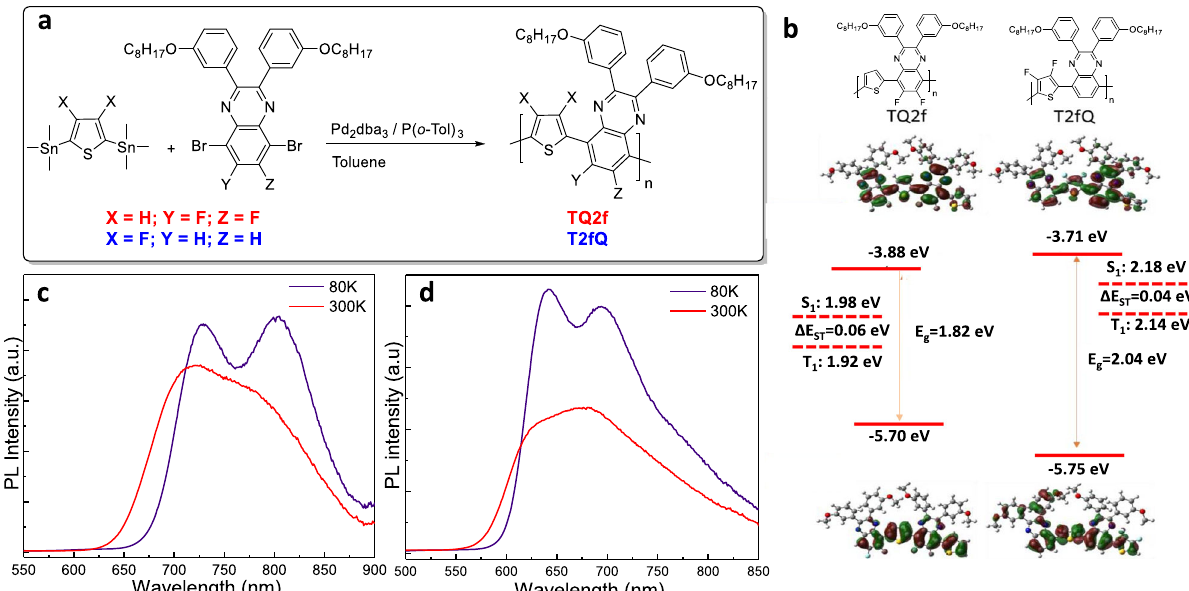
Fig. 1 Properties of the hole-transporting interlayers. a The synthetic procedure for the preparation of fl uorinated TQs. b The chemical structures of TQ2f and T2fQ used as hole-transporting interlayers, the calculated frontier orbitals and energy levels as derived from cyclic voltammetry, and absorption measurements and the lower excited singlet and triplet levels of TQ2f and T2fQ. The room temperature (RT, 300 K) and low temperature (80 K) photoluminescence spectra of c TQ2f and d T2fQ thin fi